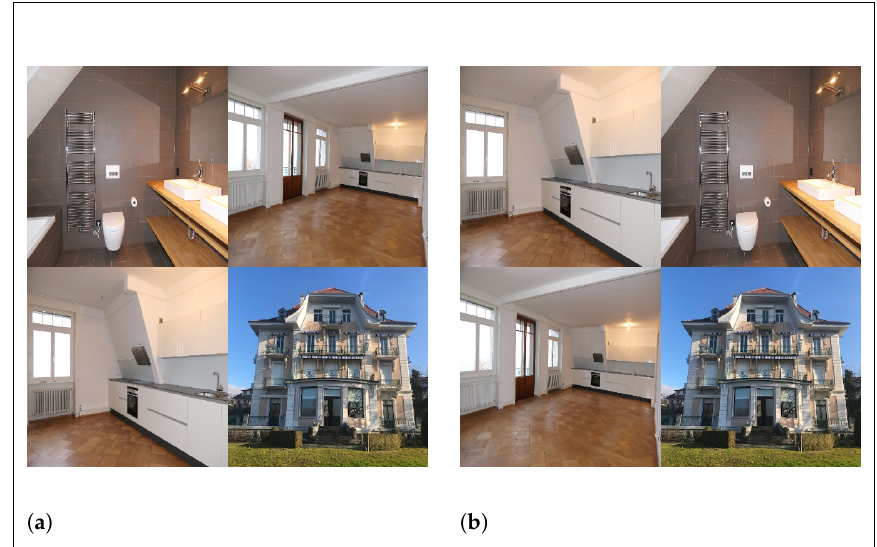
Figure 7. Example of organized ( a ) and random montage ( b ). The order of the organized montage is consistent and as follows: bathrooms on the top left, living rooms on the top right, kitchens on the bottom left, and exterior in the bottom